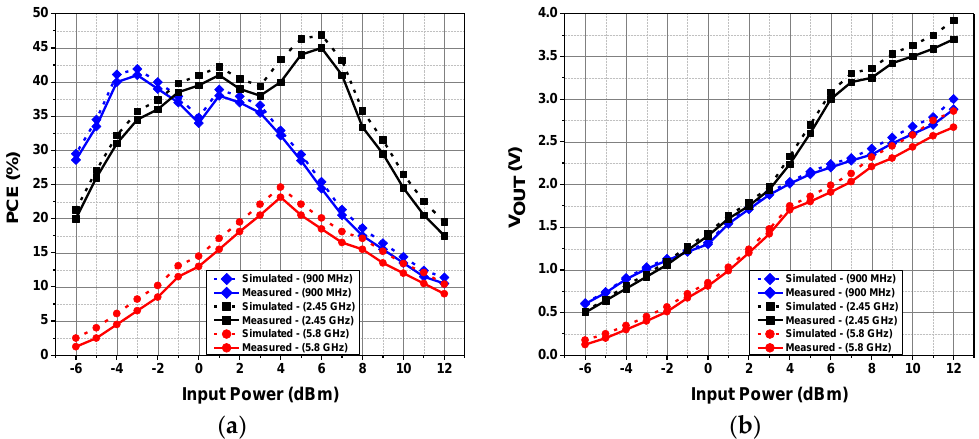
Figure 15. Simulated and measured results of the proposed circuit at different frequencies. ( a ) PCE; and ( b ) output DC voltage.